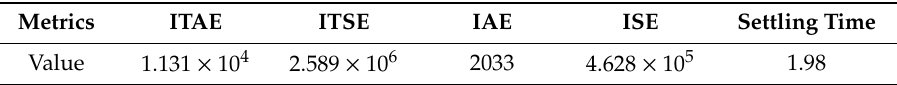
Table 10. Results for the proportional integral-derivative PID controller.